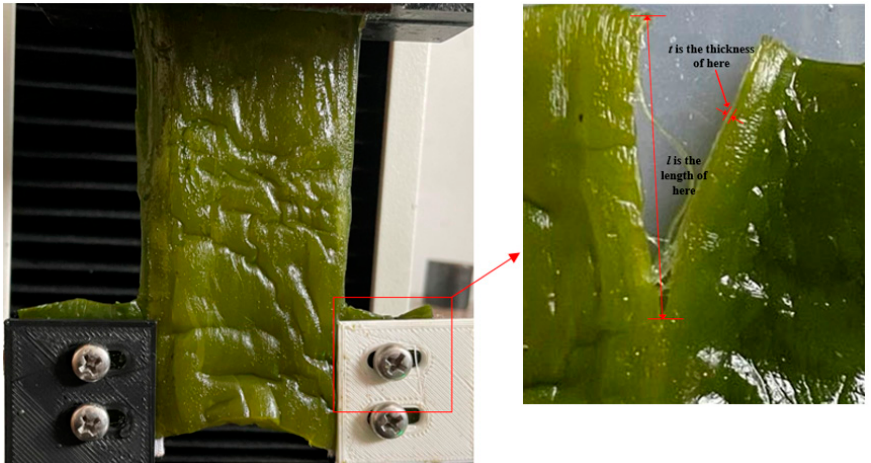
Figure 11. Schematic diagram of wakame after test.